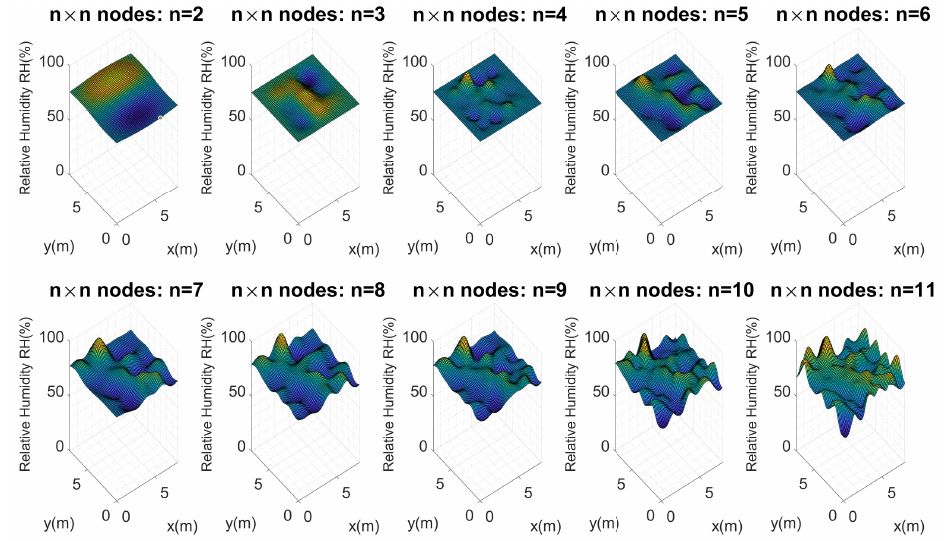
Figure 11. Soil moisture distribution maps in the test crop using n × n nodes. First experimental